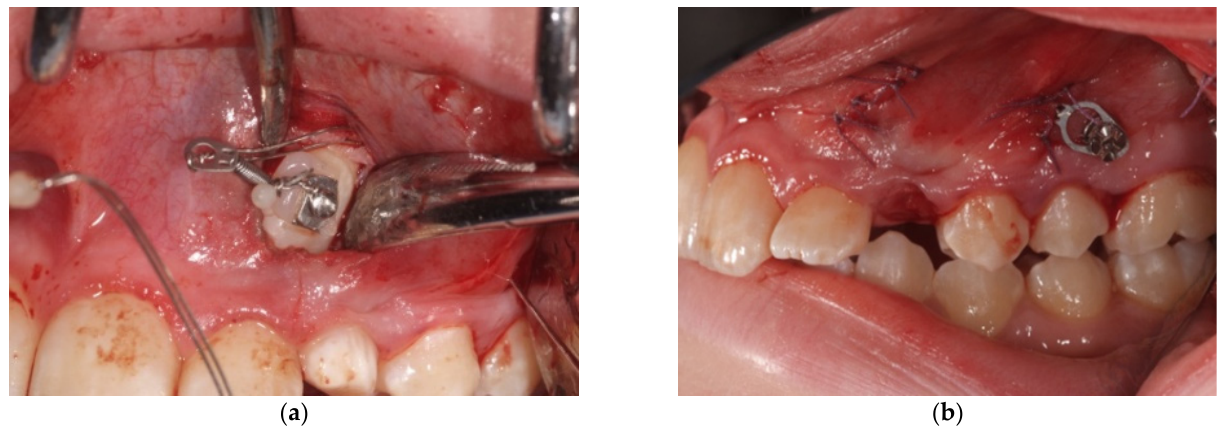
Figure 5. The button is bonded on the canine crown ( a ) and the NiTi coil spring is therefore guided in the subperiosteal